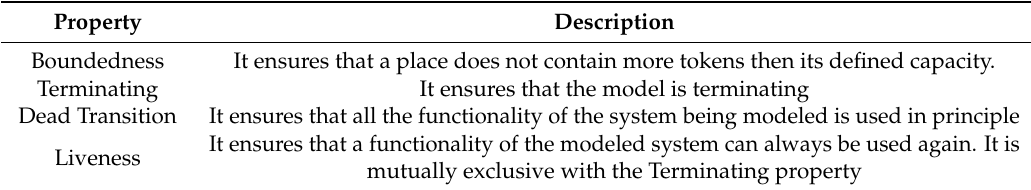
Table 1. Colored Petri Net